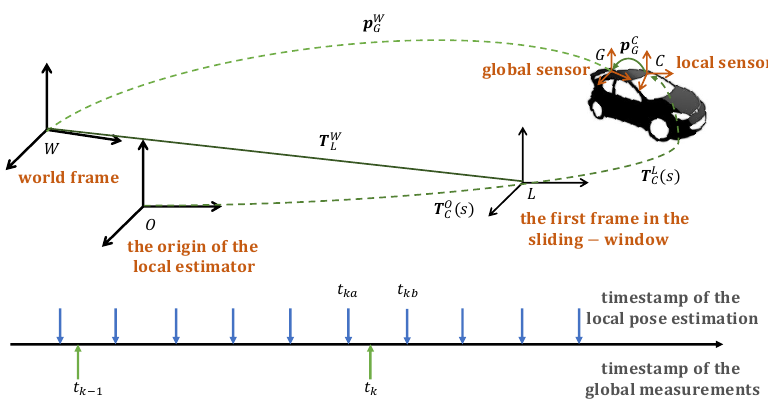
Figure 1. The demonstration of the frames and timeline utilized throughout the paper.